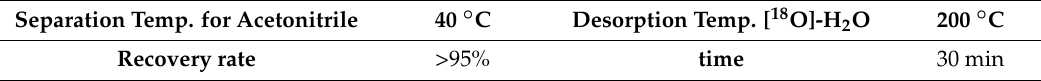
Table 6. Temperature range of the separation method using a molecular